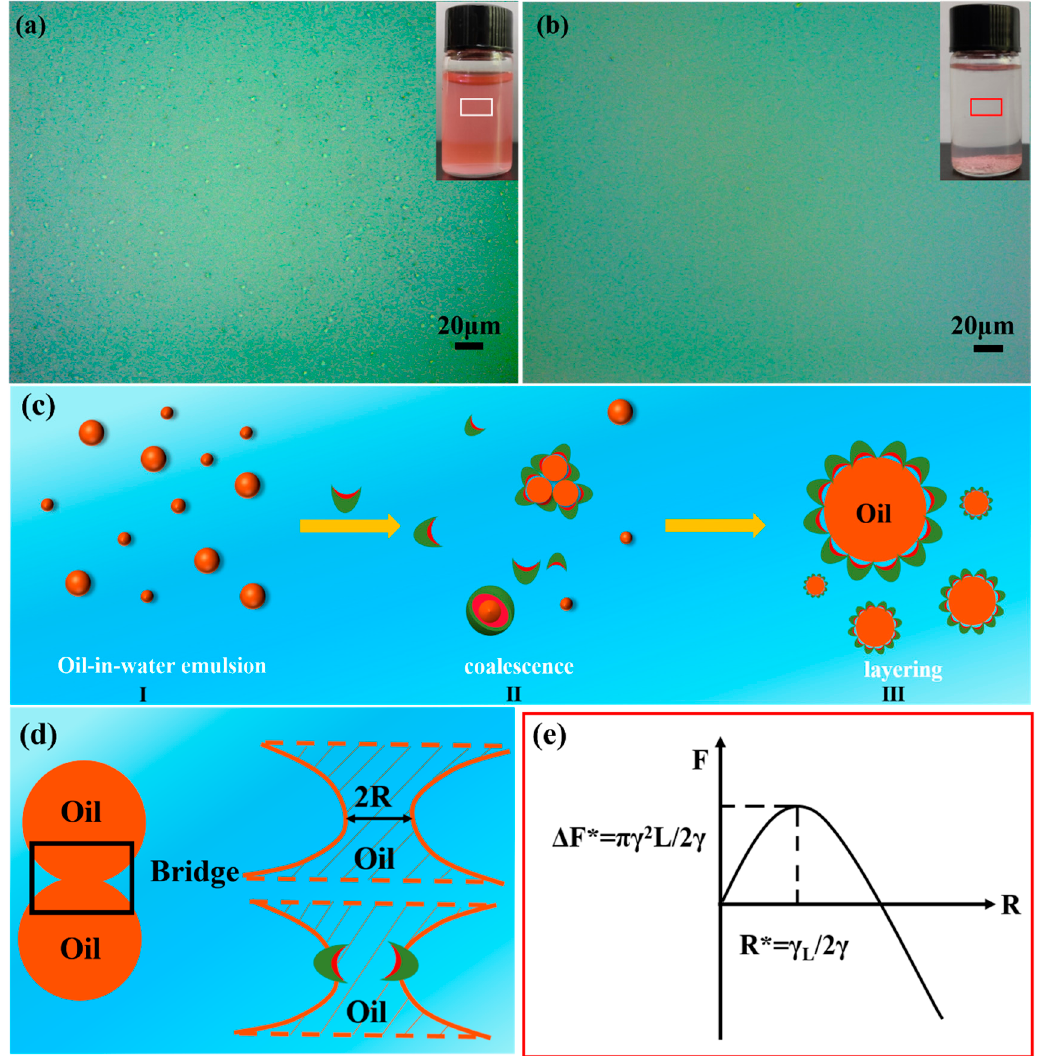
Figure 9. Digital camera and optical microscope images of the small n-heptane droplets (n-heptane content of 3% v / v ) in n-heptane–water emulsion ( a ) before and ( b ) after the addition of Janus particles. ( c ) Schematic of the separation mechanism of micro-sized oil droplets by Janus particles. ( d ) Schematic of the coalescence process between two oil droplets. ( e ) Typical plot of the free energy versus bridge